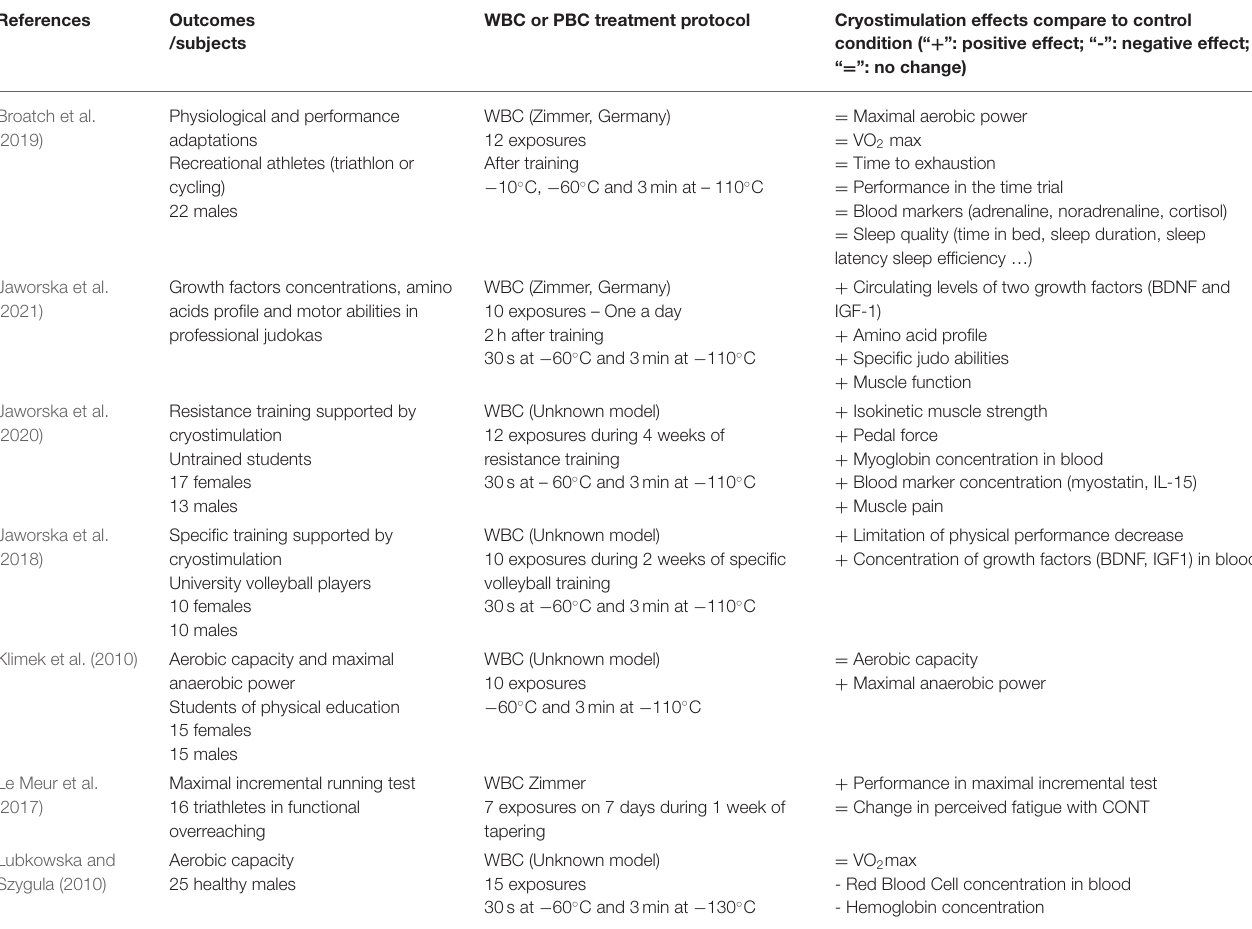
TABLE 2 | The studies investigating the chronic effects of cryostimulation on the physical